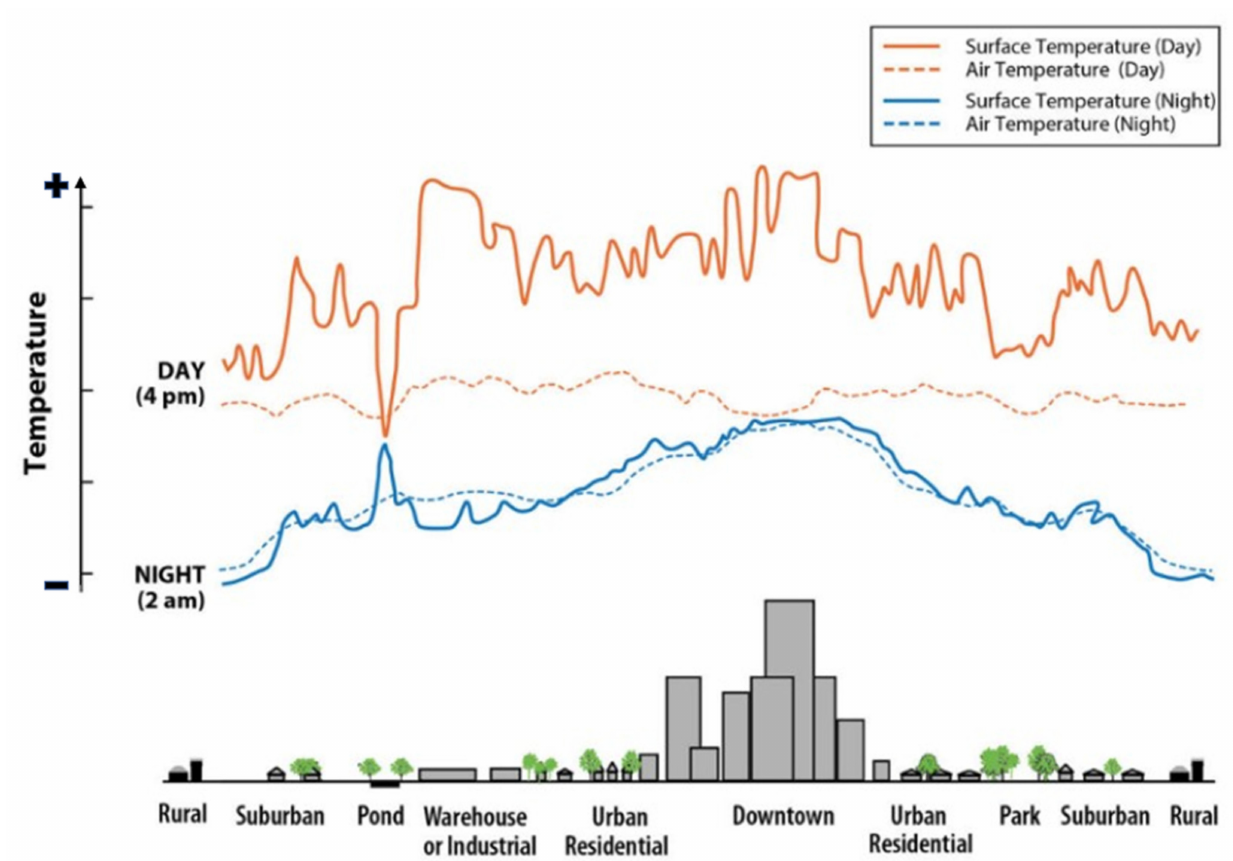
Figure 1. The temperature profile in different areas, with the formation of the UHI (adapted from